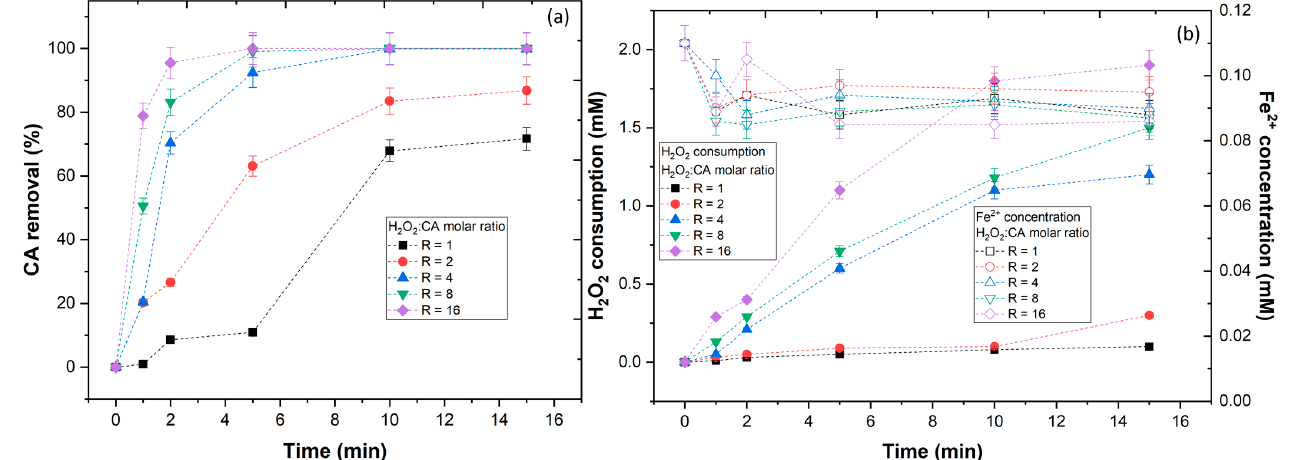
Figure 4. Evaluation of H 2 O 2 :CA molar ratio in ( a ) CA removal and ( b ) H 2 O 2 consumption and Fe 2+ concentration. Operational conditions: [CA] = 5.5 × 10 − 4 mol/L, [Fe 2+ ] = 1.1 × 10 − 4 mol L − 1 , pH = 3.0, agitation 150 rpm, temperature = 298 K, radiation UV-A, I UV = 32.7 W m − 2 , t = 15 min.